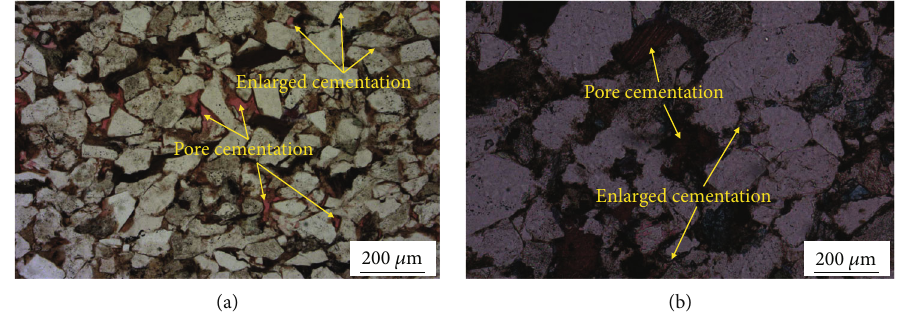
Figure 4: Characteristics of psephicity and cementation types in the (a) Jiyuan and (b) Heshui